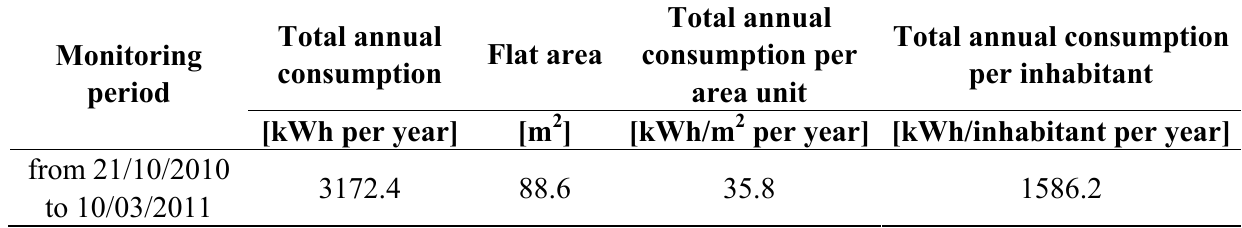
Table 7. Real heating energy consumptions for the flat analyzed.